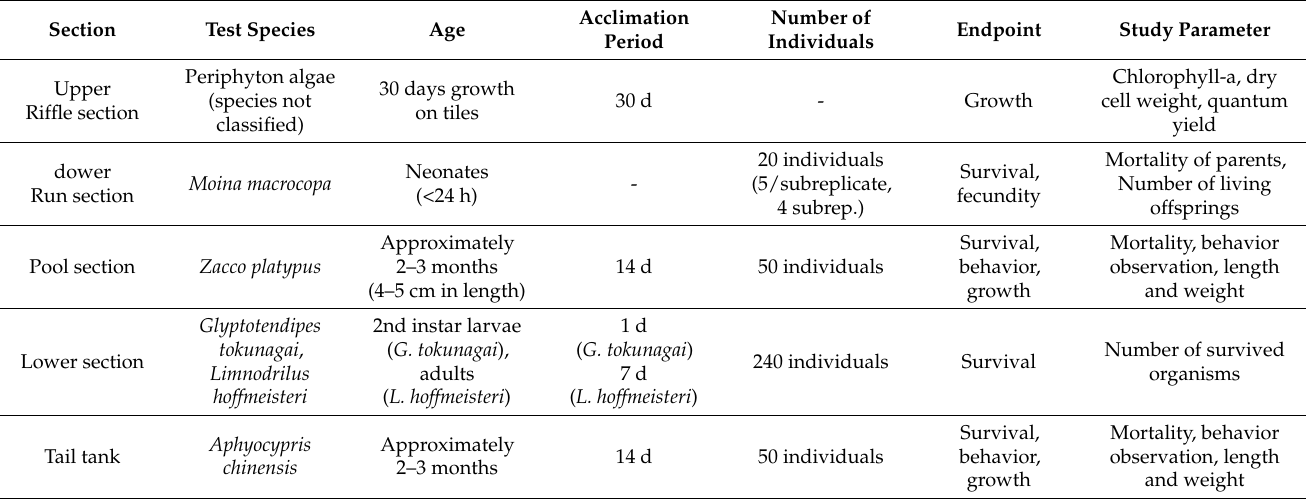
Table 2. Summary of test